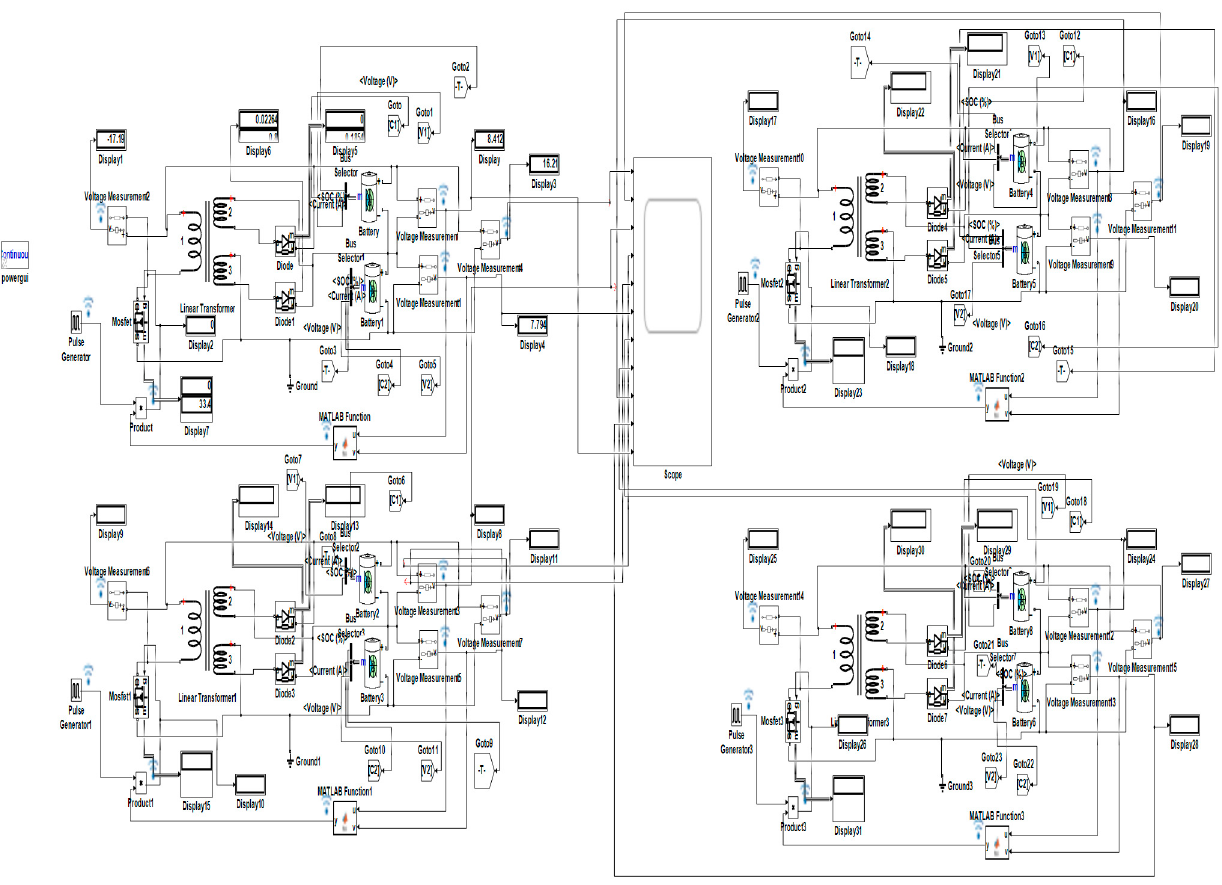
Figure 11. Active cell balancing using Simulink.